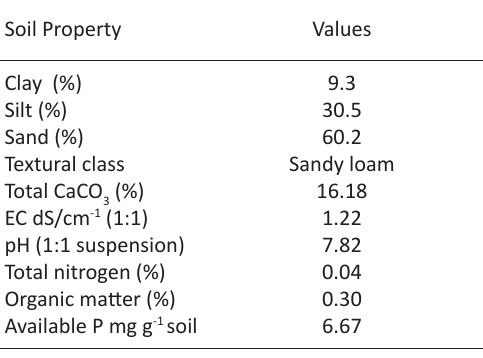
Table 1. Physical and chemical characteristics of soil used in the